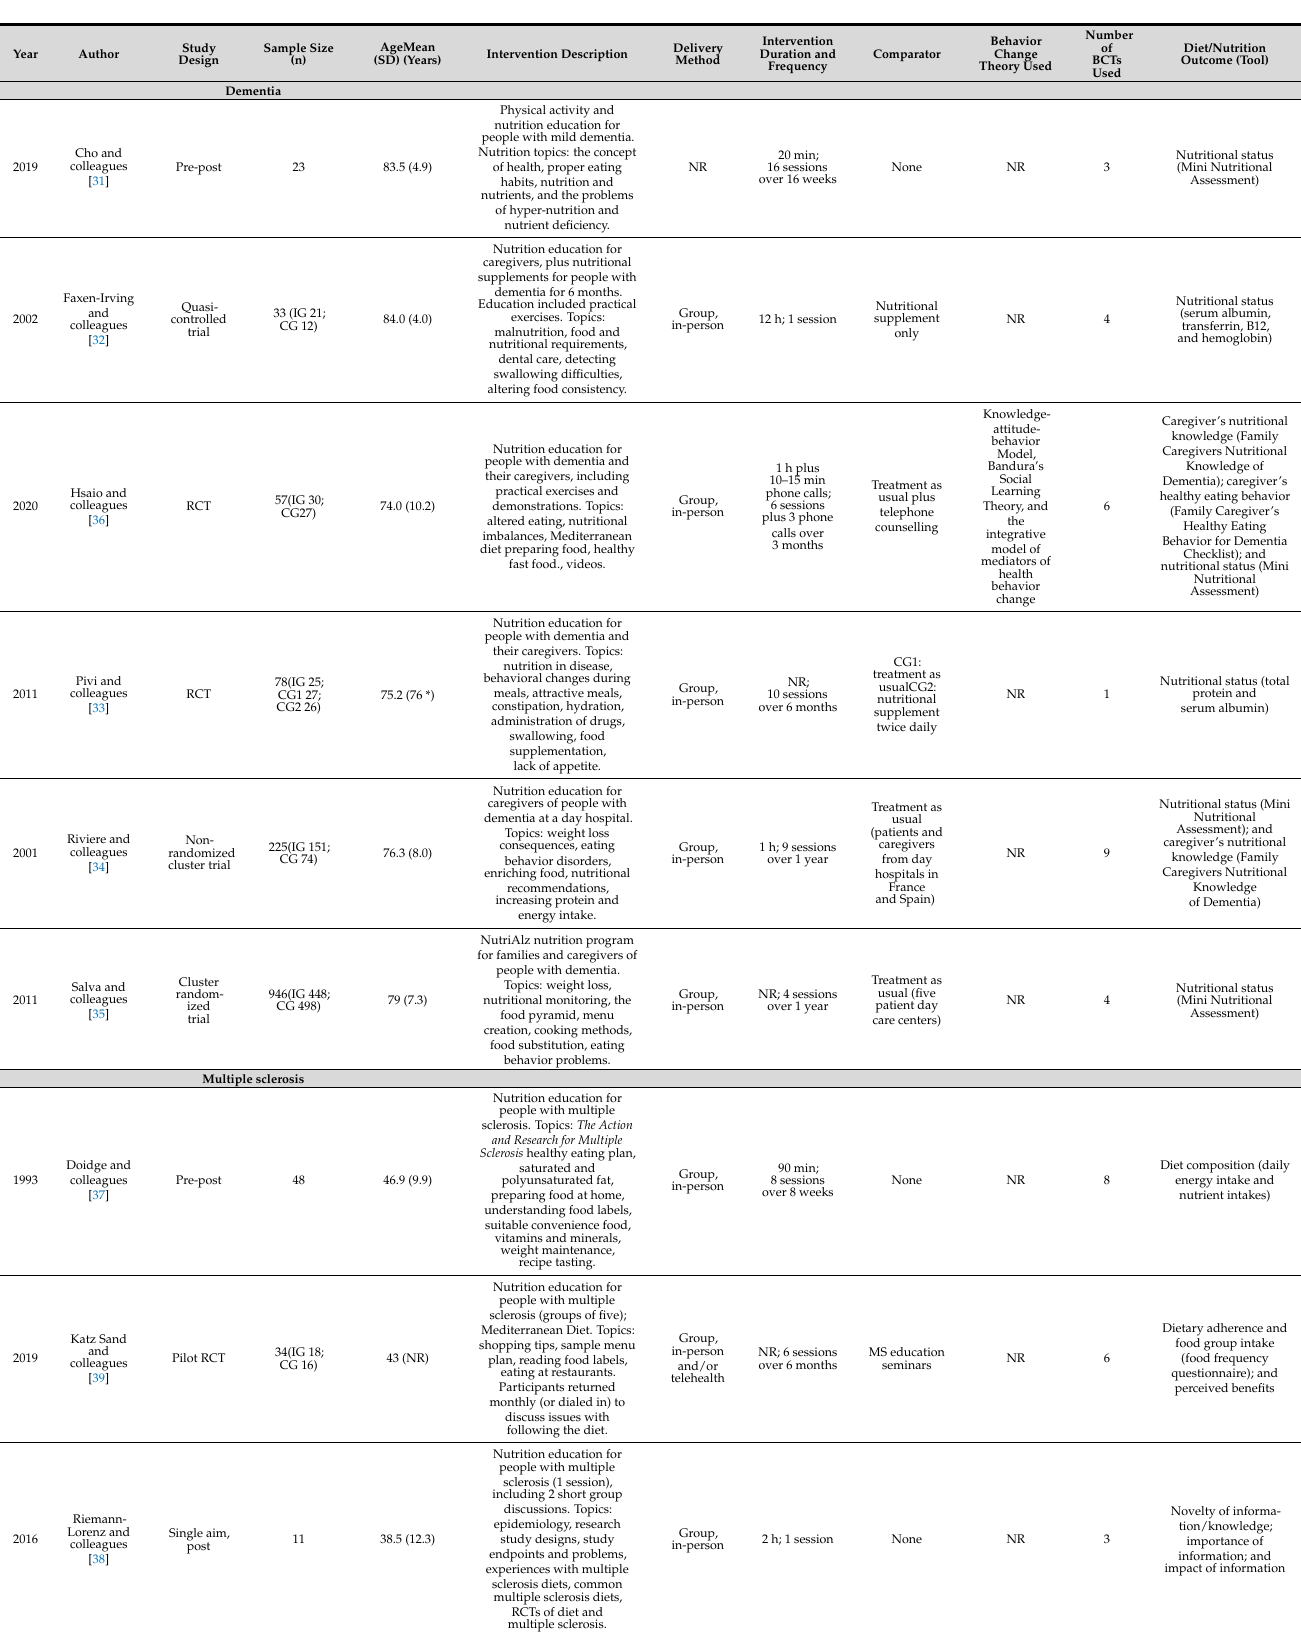
Table 1. Characteristics of the 13 studies that met the inclusion criteria of a scoping review of nutrition education programs for adults with neurological